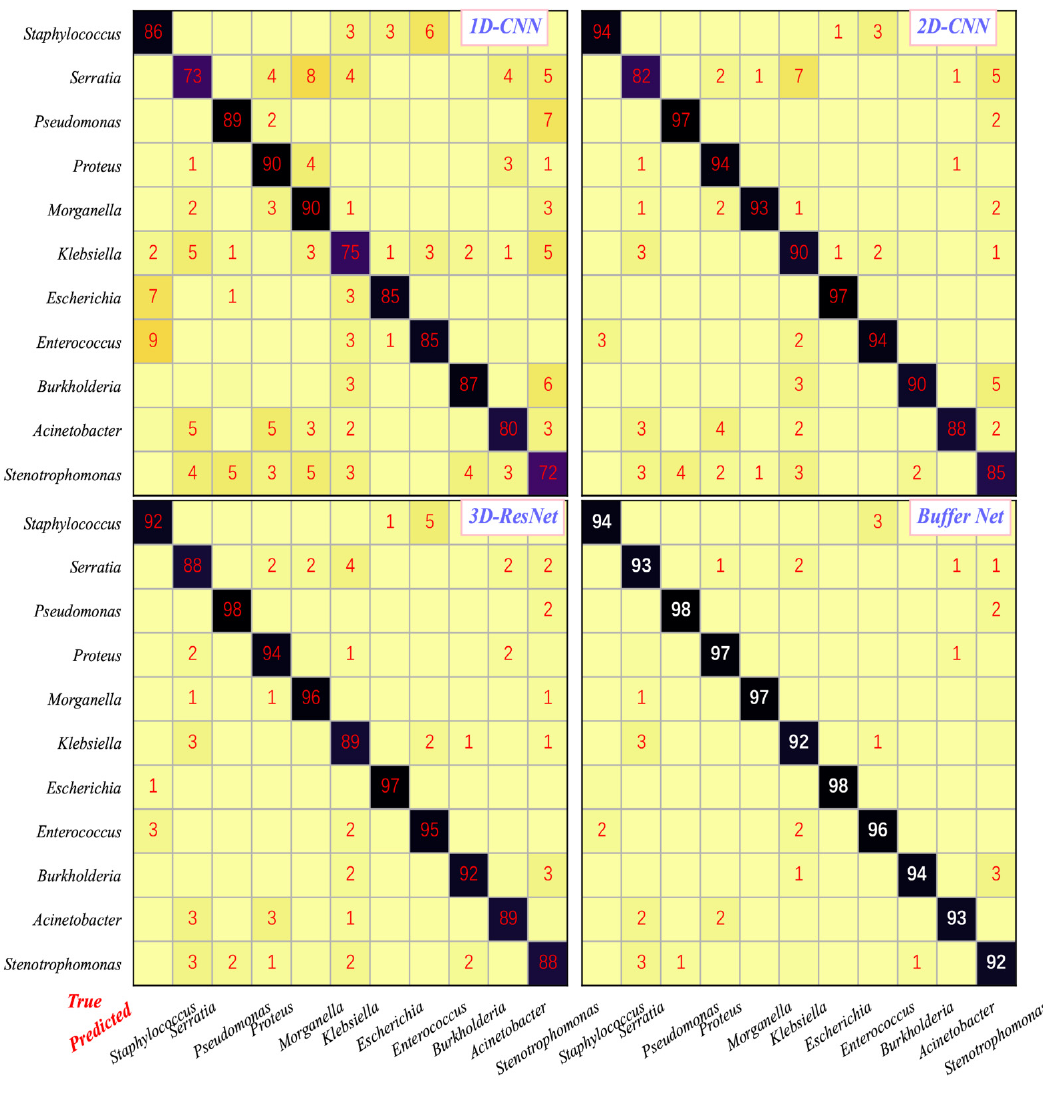
Figure 5. The confusion matrix of differentiating genera of Buffer Net, 1D-CNN, 2D-CNN and 3D-ResNet. The x-axis represents the genera predicted by our system, while the y-axis represents the underlying facts. Entries ( i , j ) indicate the percentage of samples that actually belong to class i that are judged to be of class j ; entries along the diagonal indicate the discrimination accuracy of the model we developed for each genus, and off-diagonal entries indicate the misclassification accuracy. The algorithm name was presented in the top right corner of each subplot. The highest accuracy for identifying each bacterial genus was marked by bold white among these four algorithms. Accuracies with less than 1% were not presented in the confusion matrix. All classification probabilities shown in red. The probability on the diagonal represents the correct rate. In particular, white represents the highest accuracy of the four algorithms for each genus. The remaining probability that is not diagonally represents the error rate. Noticeably, our proposed algorithm, Buffer Net, achieved the highest accuracy of 94.9%, because it was designed to learn higher-level features. It is noticeable that the dif- ferentiation precisions of Buffer Net for all genera were over 92%, with the highest preci- sion of 98% for Pseudomonas and Escherichia. Therefore, the requirement for clinical